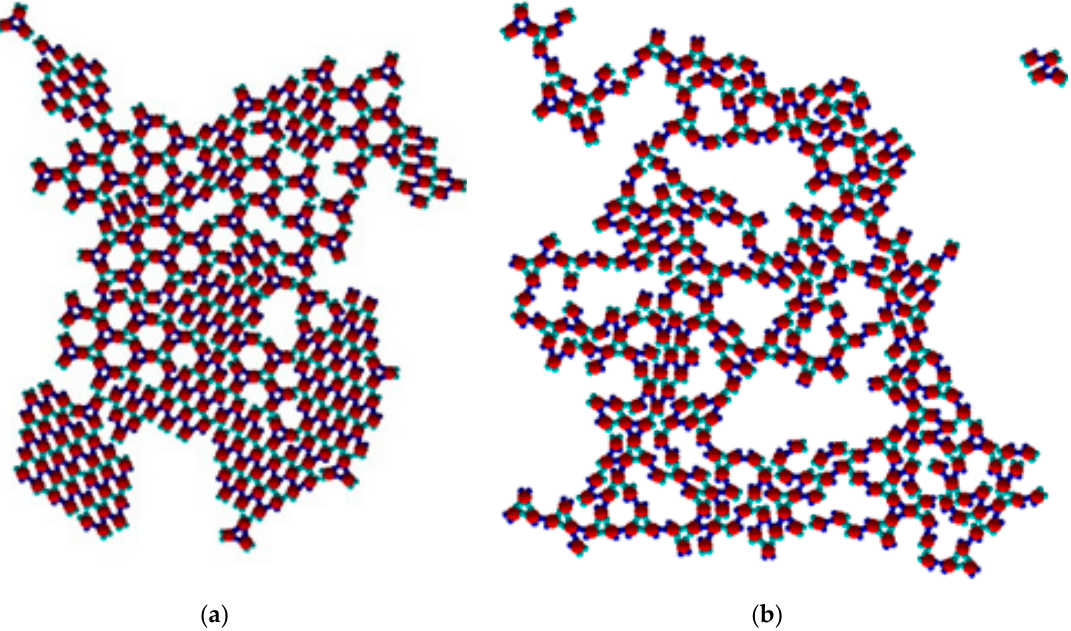
Figure 9. Coexistence of the Rh and the TriHex structure at T* = 0.08 ( a ); ramified structure at T* = 0.05 ( b ) with two kinds of trimers and small parts of the Rh phase.